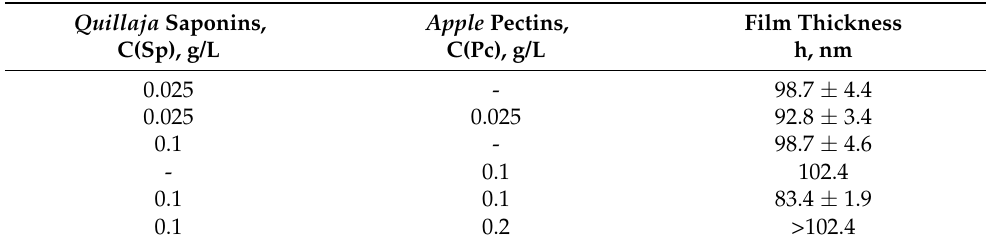
Figure 6. Snapshots of foam films stabilized by: ( a ) 0.1 g/L Quillaja saponin-only; ( b ) 0.1 g/L Apple pectin-only; ( c ) mixture of 0.1 g/L Quillaja saponins and 0.1 g/L Apple pectins; ( d ) mixture of 0.1 g/L Quillaja saponins and 0.2 g/L Apple pectins. Table 1. Film thickness of foam films from single component and mixture solutions, obtained by the use of a Scheludko–Exerowa cell.